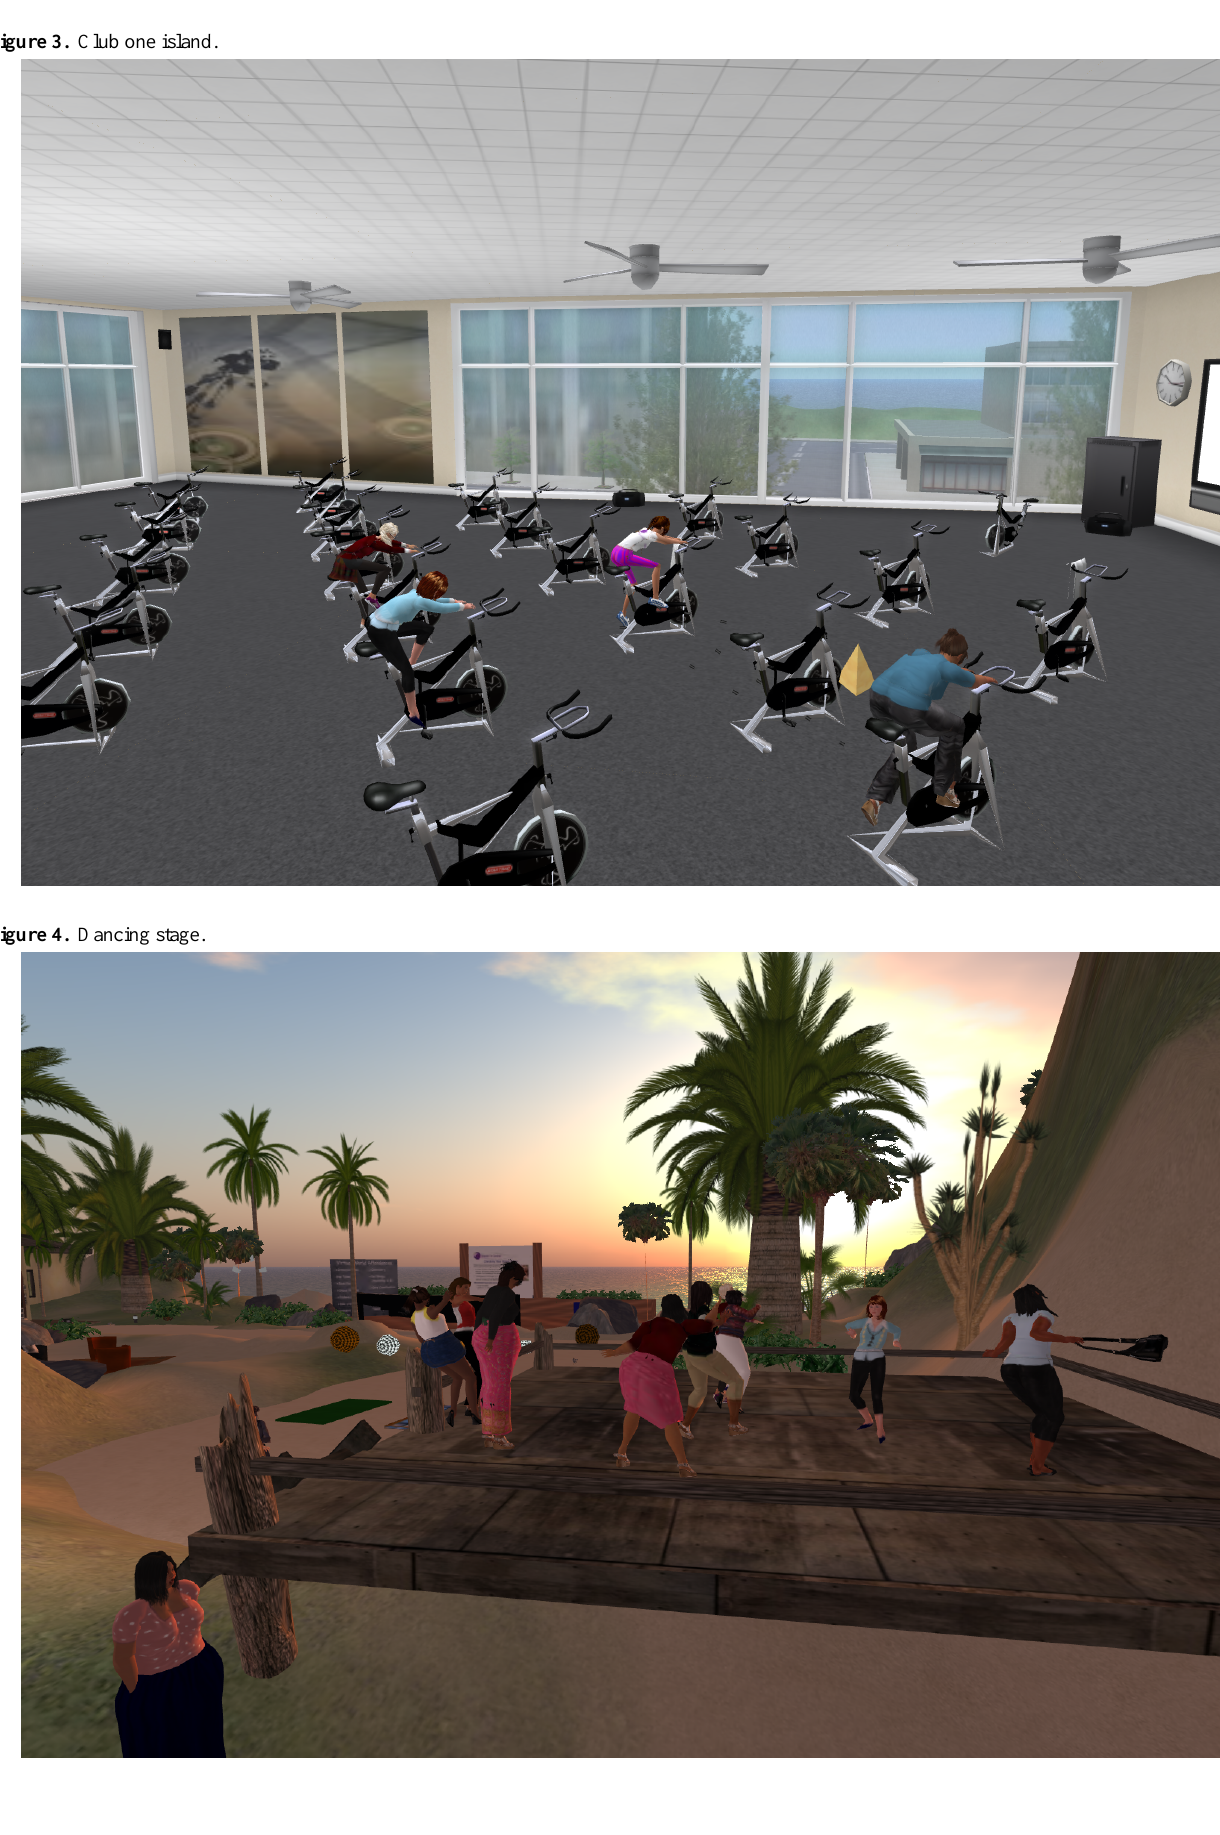
Figure 3. Club one island.